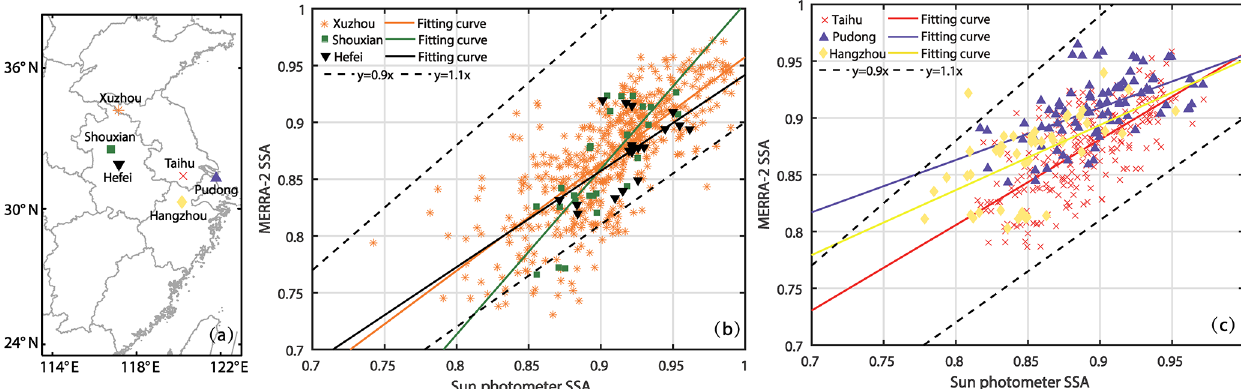
Figure 3. (a) The location of six sun photometer sites over eastern China. (b) The scatter plots of SSA between MERRA-2 and the sun photometer in Xuzhou, Shouxian, and Hefei. Orange dots represent Xuzhou samples, and the orange line is the fitting curve of Xuzhou samples while green represents Shouxian and black represents Hefei. Dashed lines are the range of ± 10% relative error. (c) The scatter plots of SSA between MERRA-2 and the sun photometer in Taihu, Pudong, and Hangzhou. Red dots represent Taihu samples, and the red line is the fitting curve of Taihu samples while purple represents Pudong and yellow represents Hangzhou. Dashed lines are the range of ± 10% relative error. Table 2. The geographical characteristics, observing period, and sample number of sun photometer sites. The fitted regression equations between MERRA-2 and sun photometer SSA are also shown here. In the equation, x represents the SSA sample, and y represents the fitted value of SSA. Location Lat, long Observing period Sample Fitted regression equation number between MERRA-2